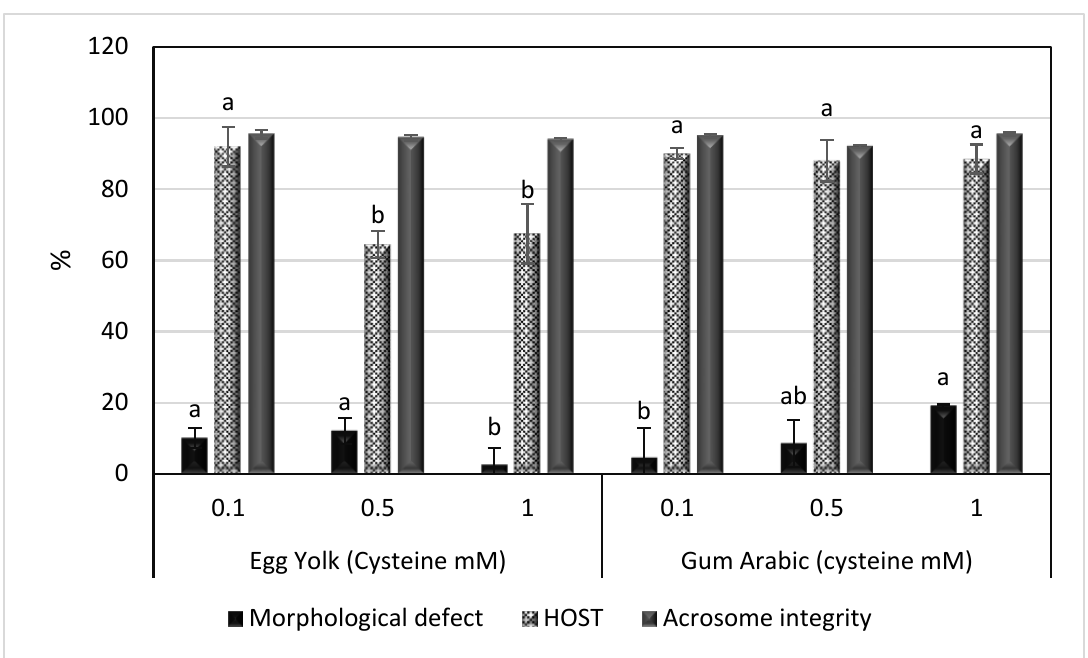
Figure 1. Mean ± SEM of morphological defects, HOST and acrosome integrity of spermatozoa in egg yolk or gum arabic extenders supplemented with different concentrations of cysteine (0.1, 0.5 and 1 mM) after cooling. HOST: hypoosmotic swelling test. a,b bars bearing different superscripts are significantly different ( p < 0.05). Table 1. Spermatozoa motility and viability parameters (mean ± SEM) in egg yolk and gum arabic extenders supplemented with different concentrations of cysteine (0.1, 0.5 and 1 mM) after cooling.